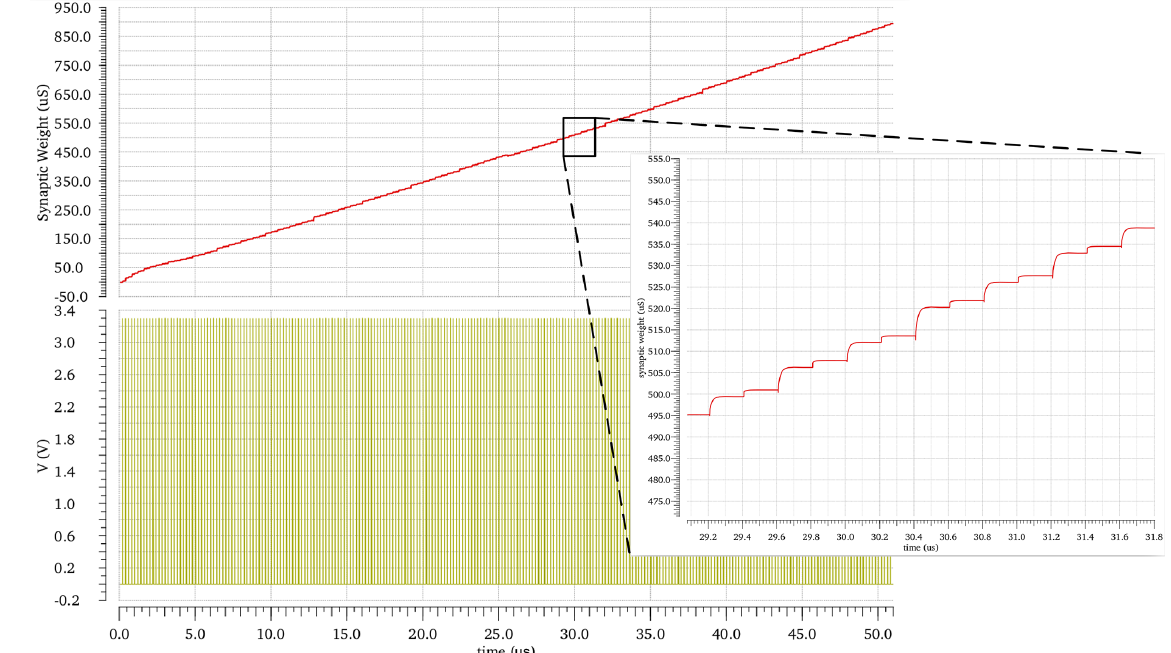
Figure 26. The synaptic weight behavior LTP at vg1 equals 0V, which is achieved by 256 input pulses applied to the 8bit counter, whose outputs control the 8bit binary digitized transistor of the synapse. Circuit conditions are V dd of 3 . 3V, and temperature equals 27 ◦ C and on the nominal process. The vg2 has a same influence on the second synapse of